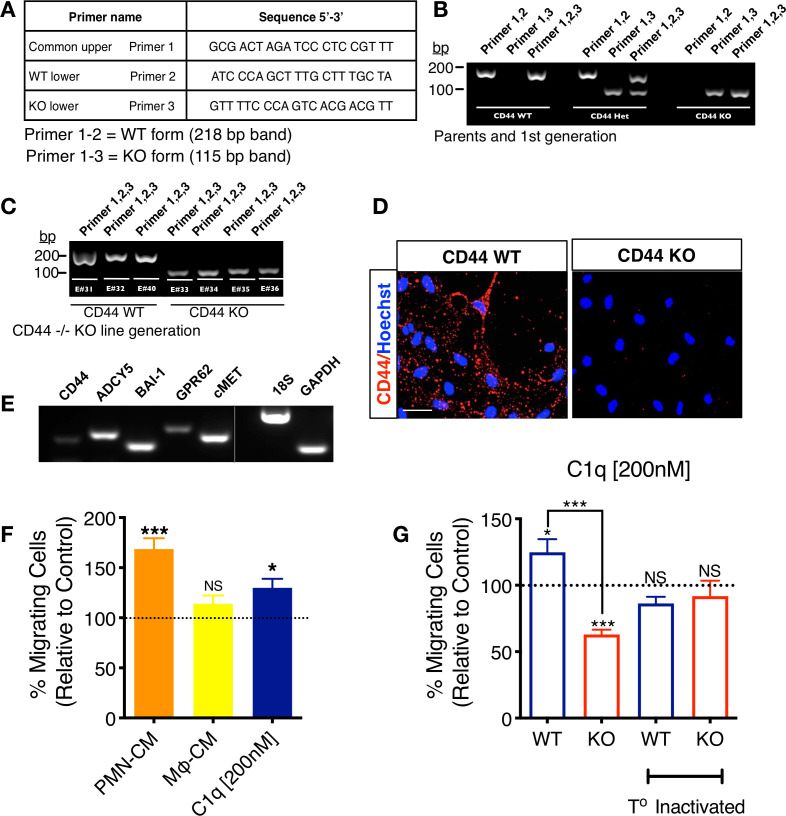
CD44 WT and KO mNSC cell line generation.Mouse NSC (mNSC) from CD44 WT and KO mice were derived from single embryo cortices at E11.5–12. DNA of parent mice and each littermate embryo was extracted from tail snips and direct PCR performed for genotyping. (A) Primers used for genotyping CD44 WT, KO, and heterozygous embryos. (B) Genotyping results of WT and CD44KO parents and first-generation heterozygous CD44 +/– colonies. (C) Genotyping results of WT and CD44 KO embryos that were used to generate CD44 WT and KO mNSC lines. (D) CD44 expression in CD44 WT and CD44 KO mNSC by immunostaining verifies positive staining only in WT cells. (E) mNSC express all C1q novel candidate receptors. mRNA RT-PCR analysis in mNSC reveals the positive expression of all C1q novel signaling candidates. (F) mNSC migrate toward PMN-CM and C1q similar to hNSC in vitro. Transwell chemotaxis assay shows that PMN-CM and C1q [200 nM] but not Mφ-CM induce mNSC chemotaxis. Data normalized to untreated control (dashed line; N = 3 biological replicates per condition with technical triplicates). Statistical analysis using one-sample t-test (NS, not significant; *p≤0.05, ***p≤0.001) for comparison with control. ANOVA analysis for comparison between groups, p=0.0018. (G) CD44 WT but not KO mNSC migrate toward C1q [200 nM] similar to hNSC in vitro. Transwell chemotaxis assay shows that C1q [200 nM] induces mNSC chemotaxis only in CD44 WT cells, while KO cells are repulsed by C1q. Both effects are blocked by temperature inactivation of C1q. Data normalized to untreated control levels (dashed line; N = 3 biological replicates per condition with technical triplicates). Statistical analysis using one-sample t-test (NS, not significant; *p≤0.05, ***p≤0.001) for comparison with control, ANOVA analysis for comparison between groups, ****p≤0.0001, and Student’s t-test for comparison between WT and CD44 KO mNSC as indicated (***p≤0.001).